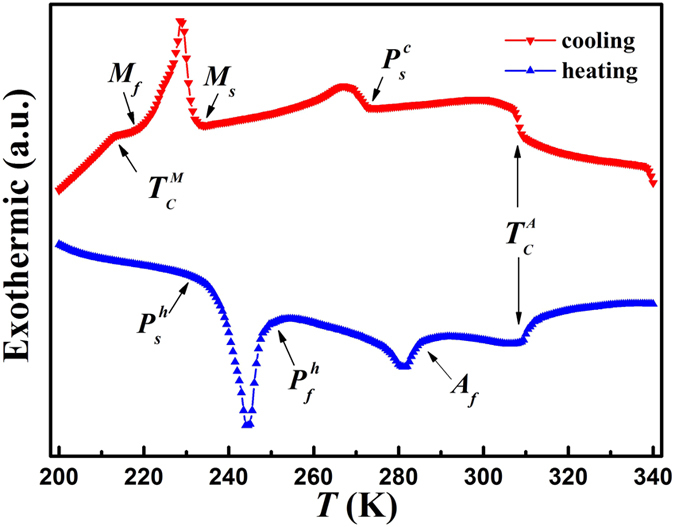
DSC curves for Ni50Mn34In15.5Al0.5 alloy upon cooling and heating.